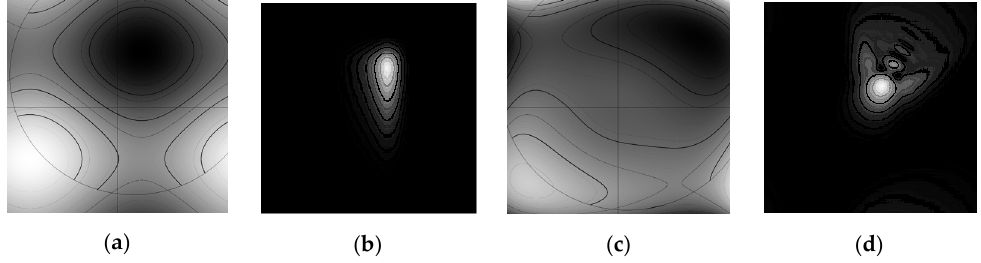
Figure 15. Increase in turbulence intensity ( r 0 = 0.1). Other parameters of numeric experiment are the same as in Figure 14. Phase distribution specified by the screen simulating atmospheric turbu- lence ( a ), amplitude distribution of a beam with initial phase profile specified by this screen ( b ), Figure 16. Results obtained with computational grid of larger (2048 × 2048 nodes) dimensions. Figure 16. Results obtained with computational grid of larger (2048 × 2048 nodes) dimensions. Other surface obtained as a result of approximation ( c ), amplitude of a beam ( d ) with initial phase pre- Other parameters are the same as in the previous example (Figure 15, Table 6). Phase distribution parameters are the same as in the previous example (Figure 15, Table 6). Phase distribution specified sented in Figure ( c ). specified by the screen simulating atmospheric turbulence ( a ), amplitude distribution of a beam by the screen simulating atmospheric turbulence ( a ), amplitude distribution of a beam with initial with initial phase profile specified by this screen ( b ), surface obtained as a result of approximation Table 7. Characteristics of the beam in the plane of observations calculated with increased turbu- phase profile specified by this screen ( b ), surface obtained as a result of approximation ( c ), amplitude ( c ), amplitude of a beam ( d ) with initial phase presented in Figure ( c ). lence intensity. Parameters of numeric experiment were the same as in the previous example (Fig- of a beam ( d ) with initial phase presented in Figure ( c ure 15). Table 8. Characteristics of the beam in the plane of observations. Parameters of numeric experi- ment were the same as in the previous example (Figure 16).